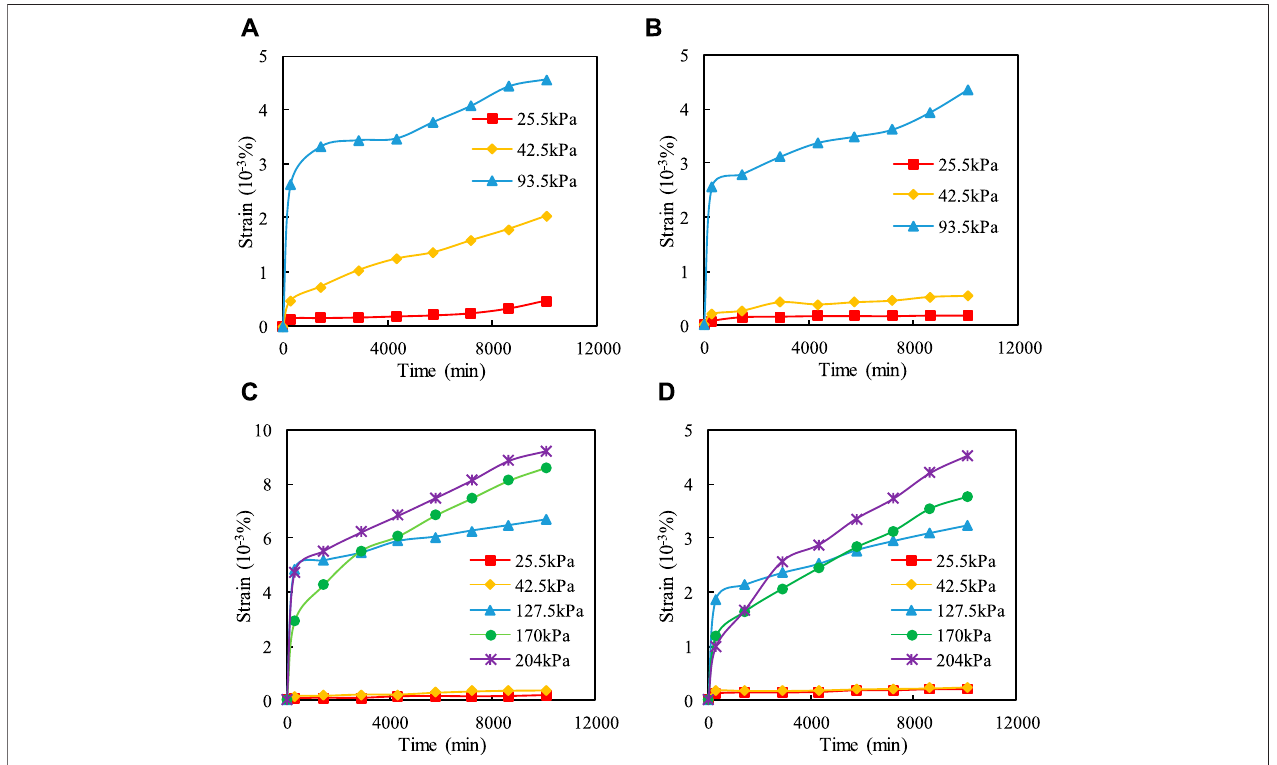
FIGURE 6 | Results of direct shear tests at the vertical stress: (A) 50 kPa; (B) 100 kPa; (C) 200 kPa; (D) 300 kPa.